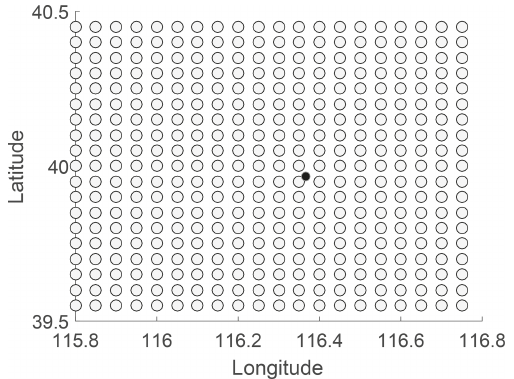
Figure 4. Distributions of the probability density of the CTH dif- ference (MODIS – radar) from four collocation methods. D m0 − r5 : radar data averaged within 5min vs. nearest MODIS; D m5 − r5 : radar 5min vs. MODIS averaged within 5km; D m5 − r30 : radar 5min vs. MODIS 30km; and D m30 − r30 : radar 30min vs. MODIS 30km.